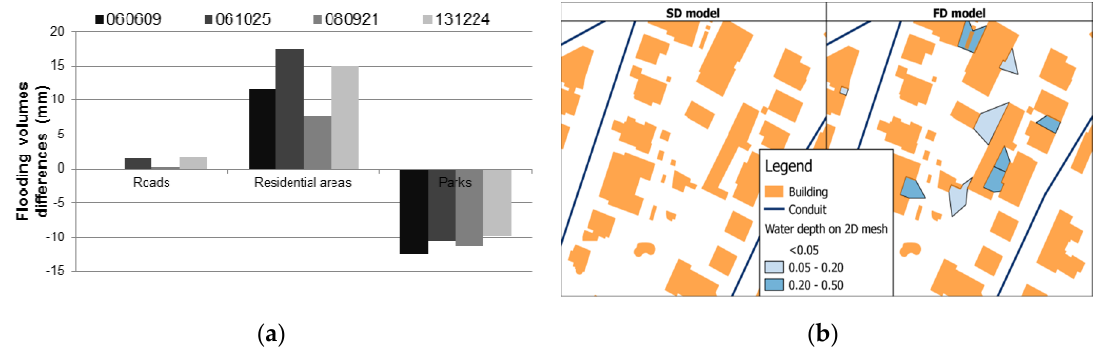
Figure 12. Differences in runoff volumes on the overland surface generated by SD and FD models in Zona Central case study: ( a ) runoff volumes distributed by land use types; and ( b ) example of runoff retained on the overland surface in FD models due to building singularities